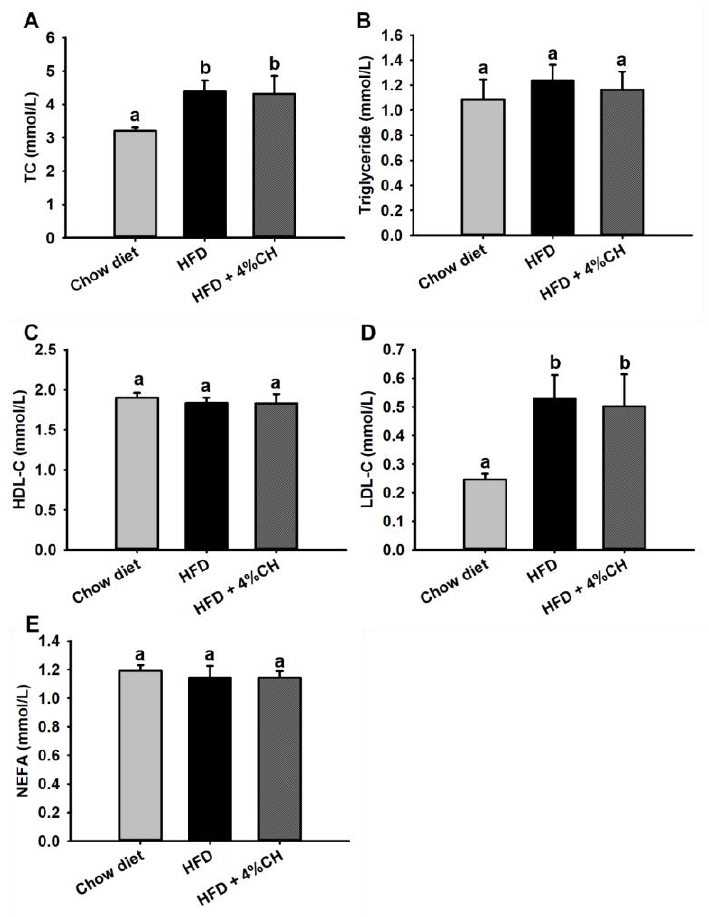
Figure 4. The effects of CH on the plasma lipid profile in HFD-induced obesity mice. The levels of TC ( A ), triglyceride ( B ), HDL-C ( C ), LDL-C ( D ) and NEFA ( E ) in the serum of mice. All data were exhibited as means ± SD ( n = 12). Different superscript letters in each column indicated a statistically significant difference at p < 0.05.